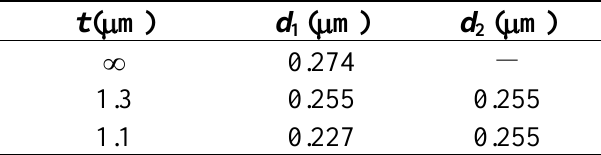
Table 1. Decay lengths of metal evanescent waves.